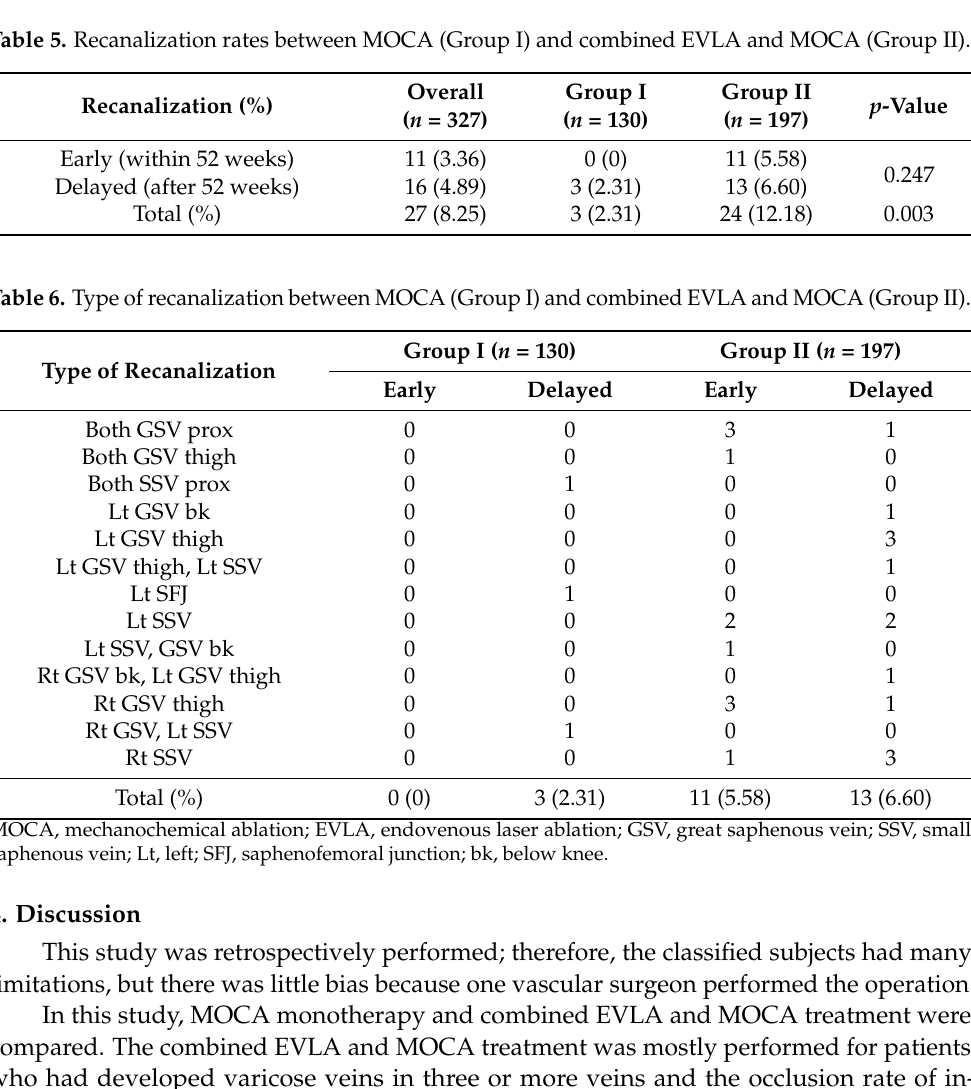
Table 4. Type of complications between MOCA (Group I) and combined EVLA and MOCA (Group II). Group I ( n = 130) Group II ( n = 197) p -Value Type of Complication Within 4 Weeks Within 4 Weeks Edema 0 2 Hemoglobinuria 1 0 Local skin infection 0 1 Pain along vein 0 1 Pigmentation 2 1 Rash, thrombophlebitis 2 8 Wound oozing